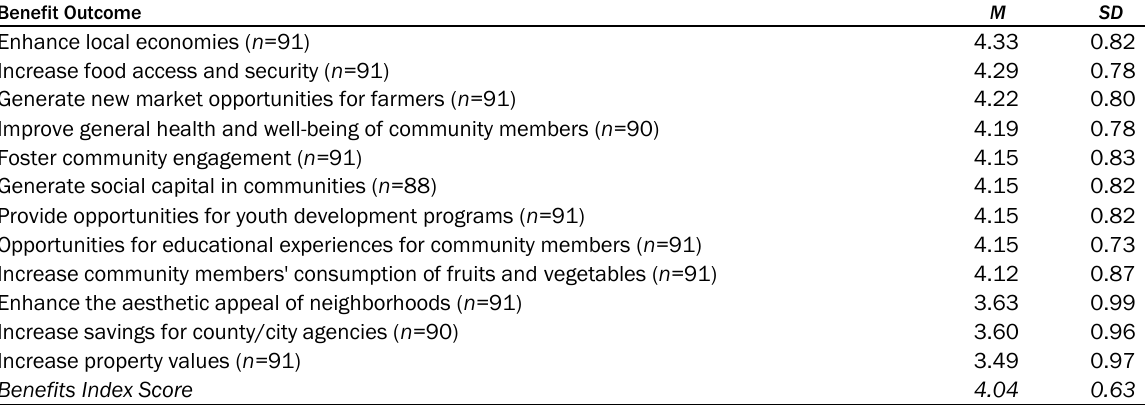
Table 5. Perceived Benefits of Local Food Production